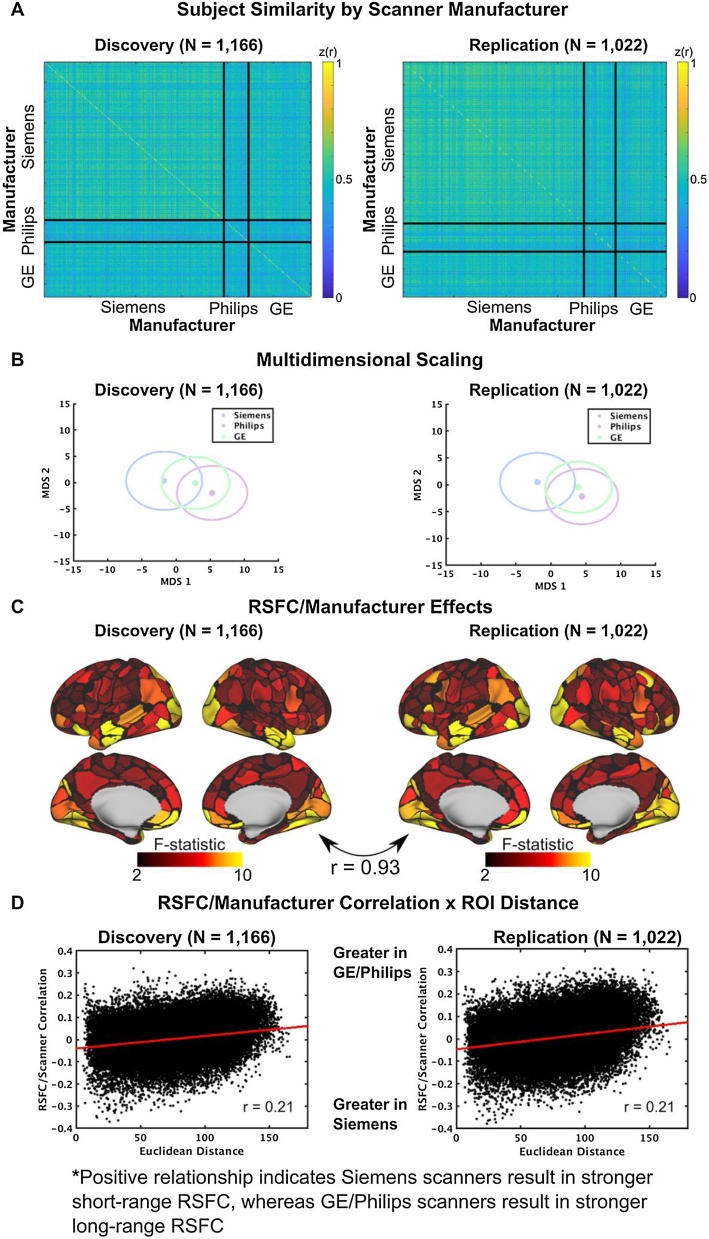
Scanner manufacturer effects. (A) RSFC similarity across individuals, sorted by scanner manufacturer (Siemens, Philips, GE). Each cell represents the whole brain correlation (similarity) between a pair of participants. Siemens scanners demonstrated higher similarity across participants than Philips or GE scanners. (B) MDS plots. Within these plots, each data point represents the mean across participants in multidimensional space, colored by the scanner manufacturer. Circles around the data points represent the 2-dimensional standard error of the mean. RSFC obtained with GE/Philips scanners are clearly dissociable from RSFC obtained with Siemens scanners (C) Correlations between RSFC and scanner manufacturer. Strong positive and negative correlations between the visual network and several other networks. (D) RSFC/scanner correlations demonstrate distance dependence, such that short-range ROI correlations, especially within the visual network, are weaker in GE/Philips scanners compared to Siemens, whereas long distance correlations are stronger in GE/Philips scanners compared to Siemens.